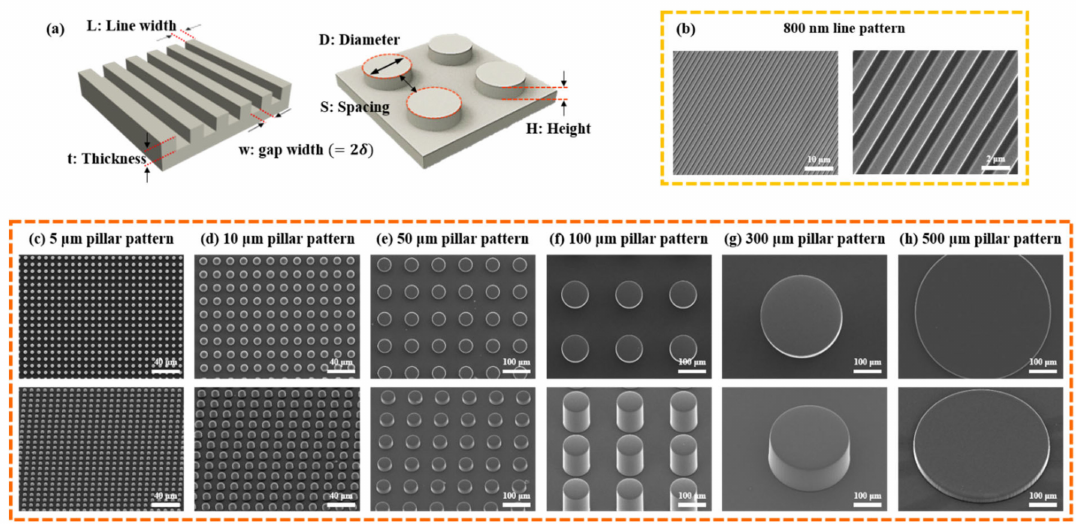
Figure 1. ( a ) Definition of the structural features of the micro-pillar and nano-line structures. ( b ) SEM images of the nano-line patterns with a width of 800 nm, spacing of 800 nm and height of 400 nm. ( c – h ) SEM images of the diverse dimensions of the micro-pillar pattern PDMS mold. Note: diameter (D), spacing (S) and height (H) for ( c ) 5 µ m, 5 µ m and 5 µ m; ( d ) 10 µ m, 10 µ m and 6 µ m; ( e ) 50 µ m, 50 µ m and 20 µ m; ( f ) 100 µ m, 100 µ m and 120 µ m; ( g ) 300 µ m, 300 µ m and 120 µ m; and ( h ) 500 µ m, 500 µ m and 20 µ